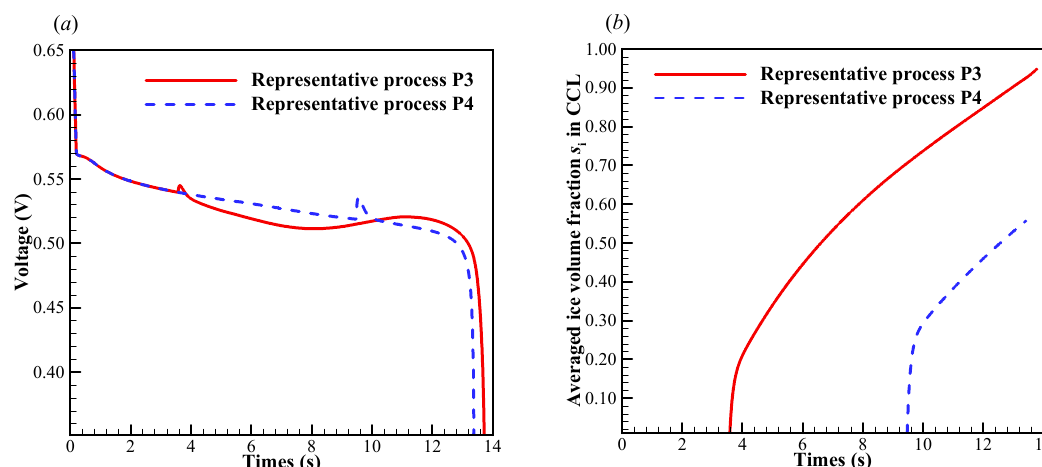
Figure 11. Evolution of ( a ) the cell voltage, ( b ) the volume-averaged ice volume fraction in CCL. The cell starts from − 20 ◦ C with initial membrane water content λ 0 = 7.8 and current density I 0 = 0.33 A/cm 2 . The cell is supplied with dry hydrogen and oxygen. The stoichiometry ratio of the mass flow rate is 2.0. The background pressure is 1.0 atm at both the anode and cathode outlets.